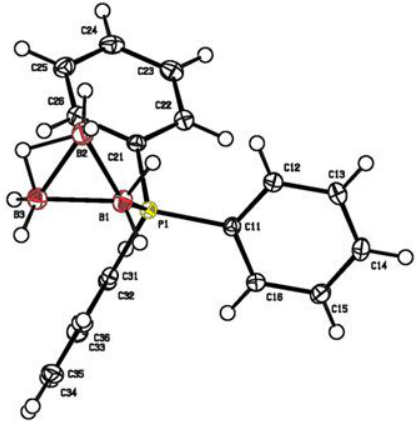
Figure 2. Structure of Ph 3 P · B 3 H 7 determined by X-ray diffraction (temperature displacement ellip- soids are shown with a 50% probability level).